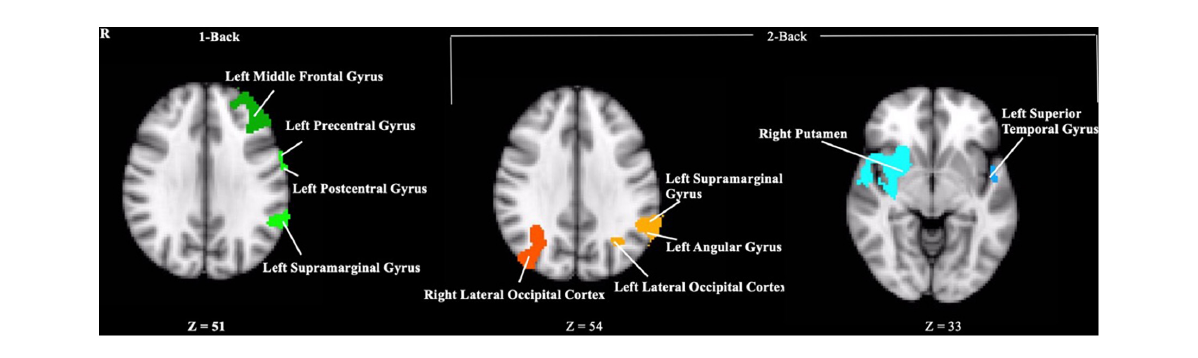
FIGURE1 Clusters where ε 4 carriers exhibited reduced activity during the n-back task compared to non-carriers. Each cluster met a cluster threshold of z > 2.3 and p < 0.05. These clusters are described further in Table 2 .